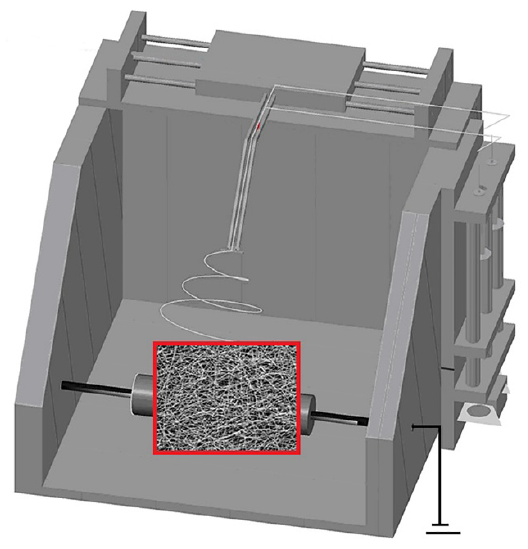
Figure 1. The schematic diagram of electro-spinning apparatus.